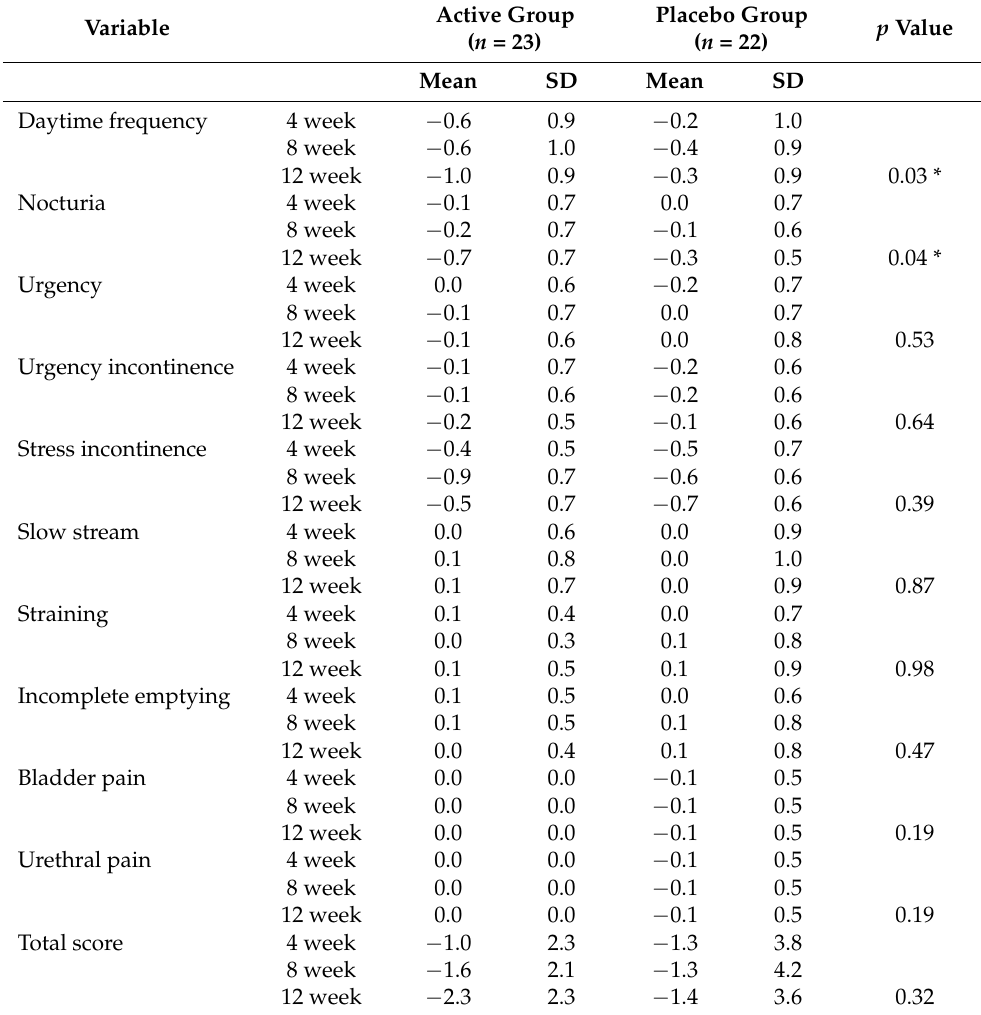
Table 3. Mean difference from the baseline for core lower urinary tract symptom scores (CLSS) in SPE treatment (active) and placebo groups with a score of 1 or higher for CLSS Q5.